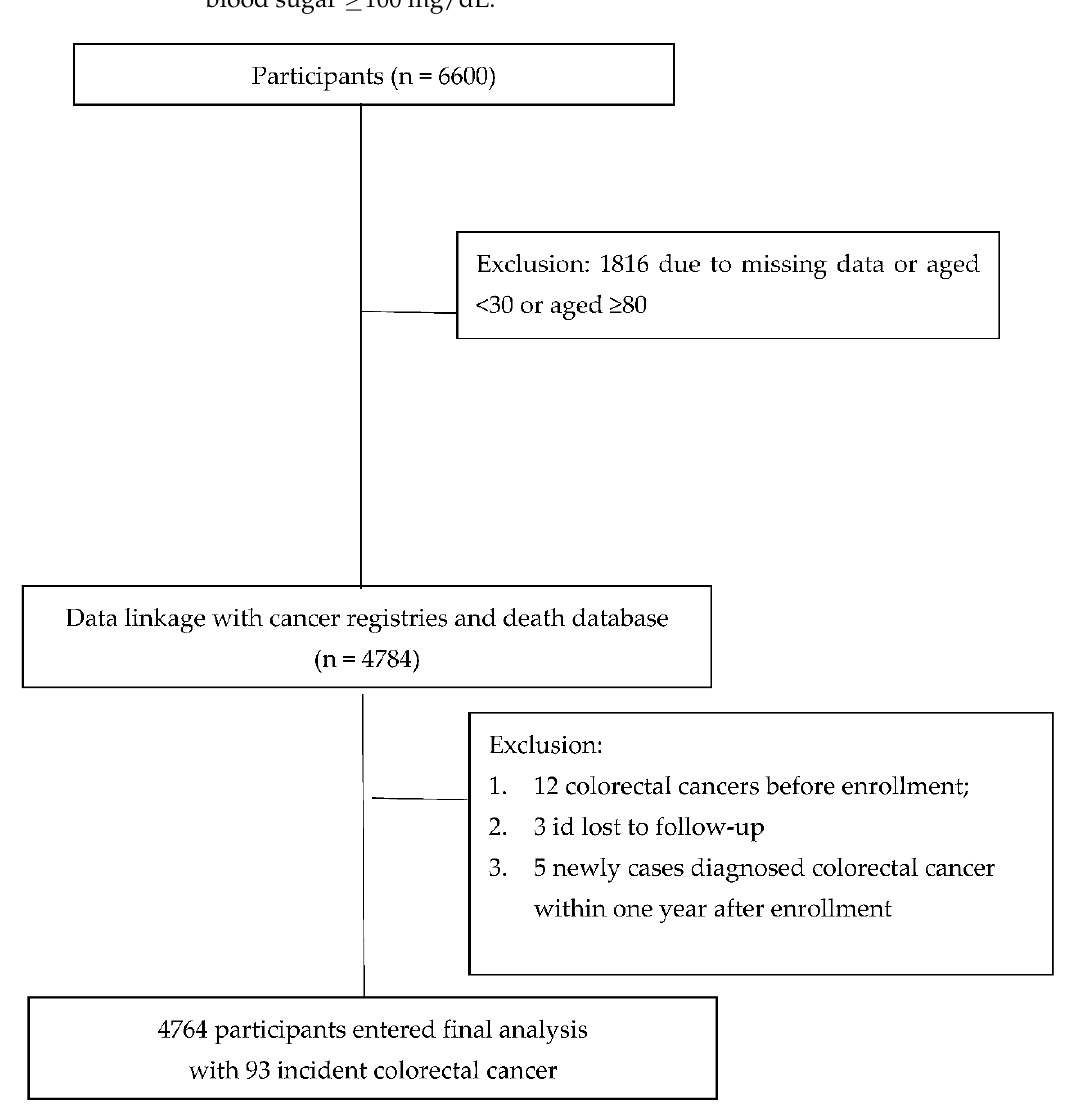
Figure 1. Flow of study participants in long-term follow-up study on colorectal cancer.